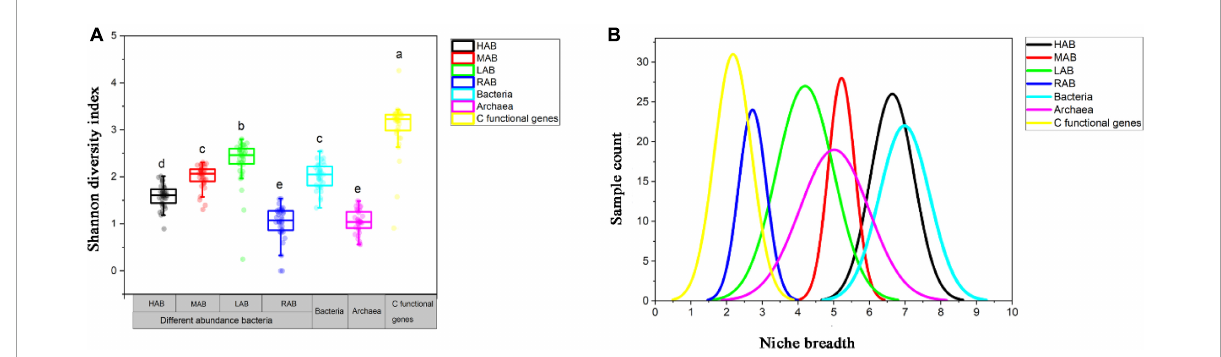
FIGURE3 Shannon diversity index (A) and niche breadth (B) of bacteria, archaea, and carbon-functional genes. The relevant abbreviations are referred to the text. Significant difference between groups are indicated with lowercase letters ( p < 0.05).